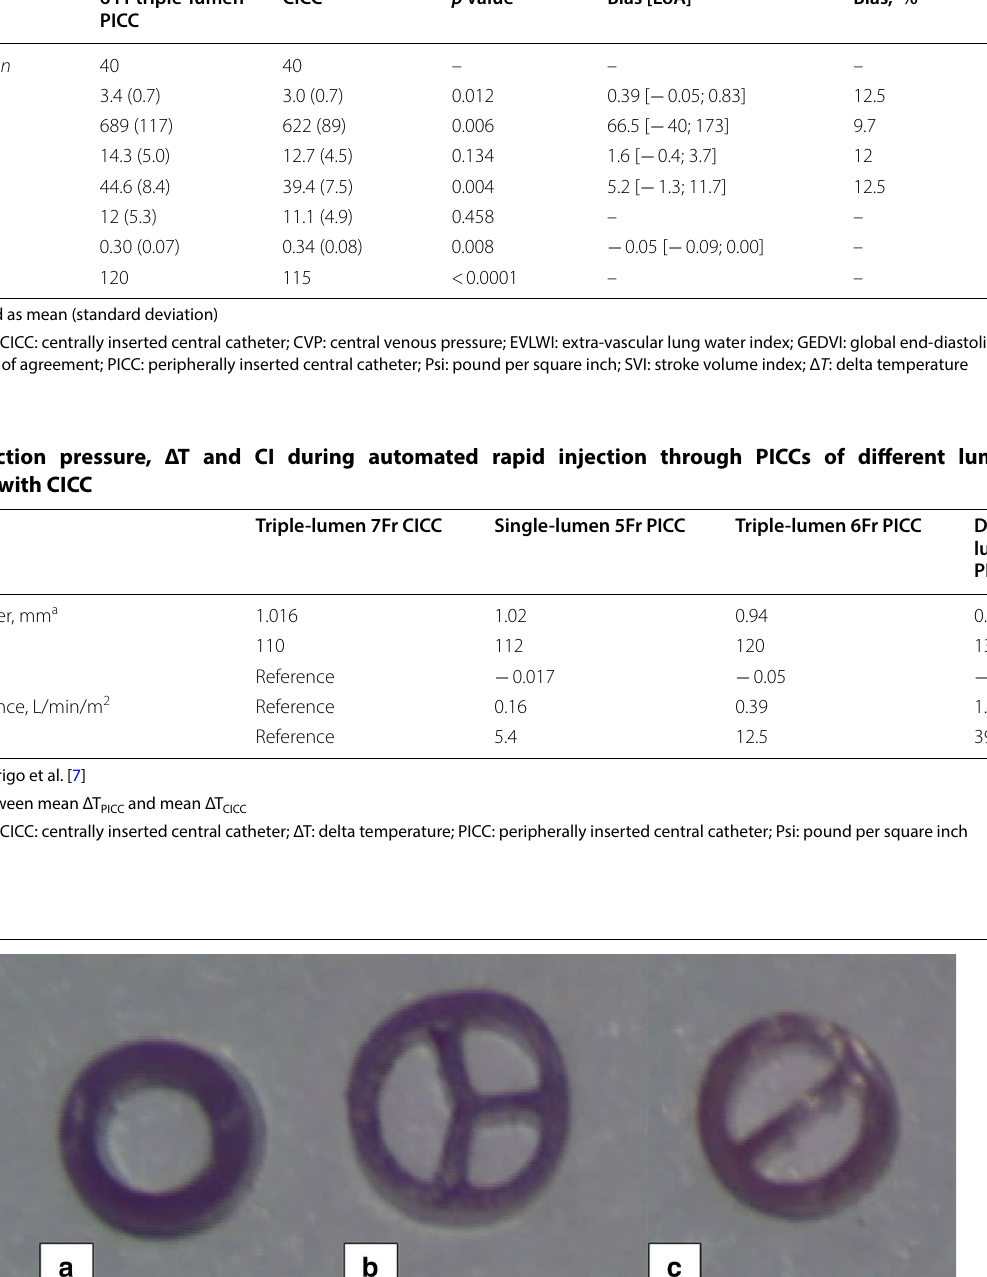
Table 5 Automated injection phase: Comparison between triple-lumen 6Fr PICC vs. CICC